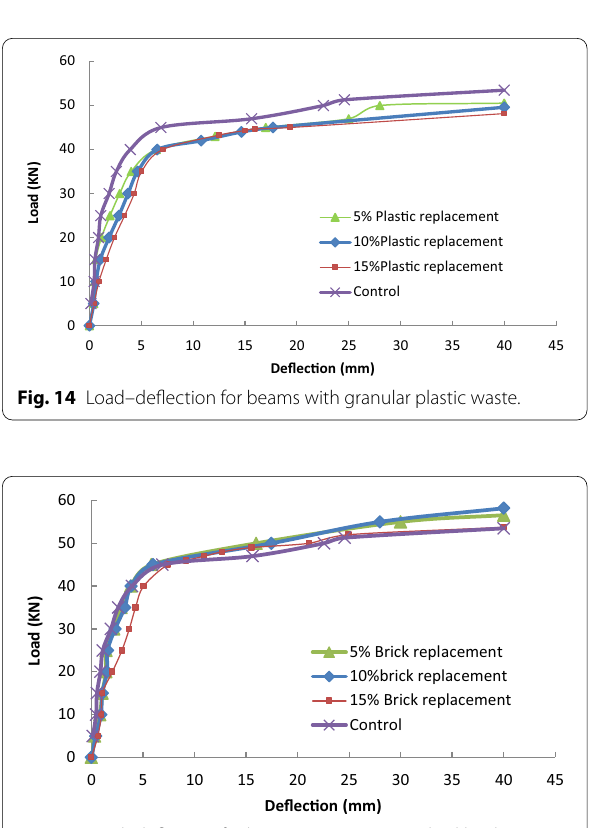
Fig. 15 Load–deflection for beams containing crushed